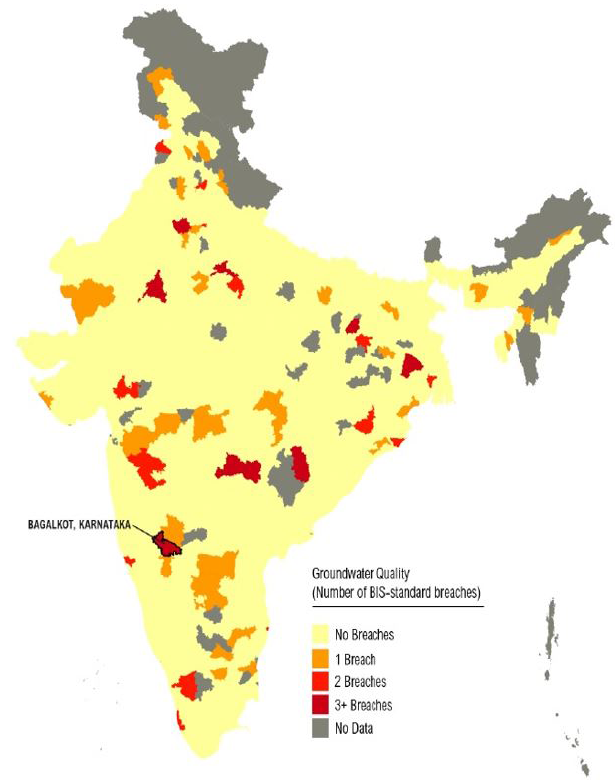
Figure 1. Groundwater quality (number of BIS-standard breaches; World Resources Institute,